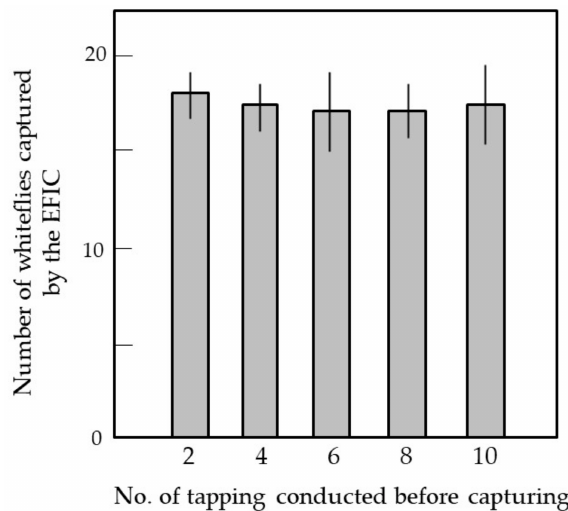
Figure 5. Capture of whiteflies that flew up after final tapping of a tomato plant. Twenty adult whiteflies were transferred to a potted plant and forced to fly up by tapping, which was repeated every time whiteflies returned to the plant. The whiteflies exhibited repeated flush-and-return behaviors in response to successive tappings. After the final tapping, the whiteflies that flew up were caught by the electrostatic flying insect catcher (EFIC). The means and standard deviations were calculated from five experimental replicates. There was no significant difference in the number of whiteflies captured according to the number of tappings prior to